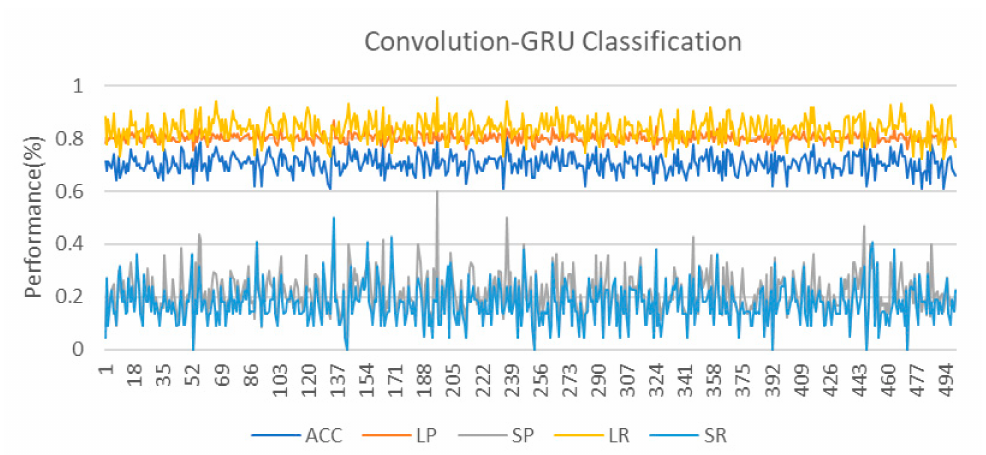
Figure 7. The result of 500 cross-validations on the convolution-GRU network. It should be noted that we are still performing 10-fold cross-validation, so 500 cross-validation is actually 50 rounds of 10-fold cross-validation. The changes in classification performance are almost entirely derived from data division and classifier parameter